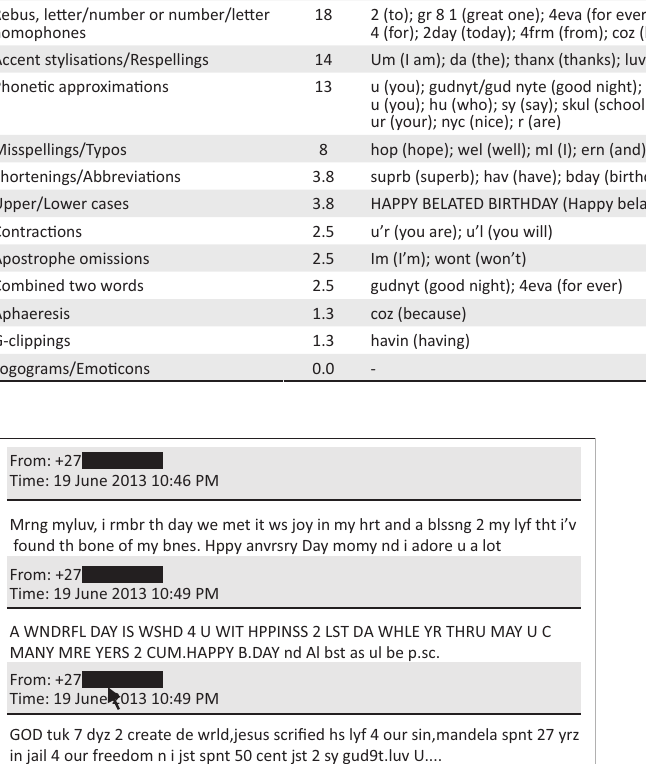
FIGURE 1: Sample of participants’ electronically transmitted SMS language features and corresponding full versions.